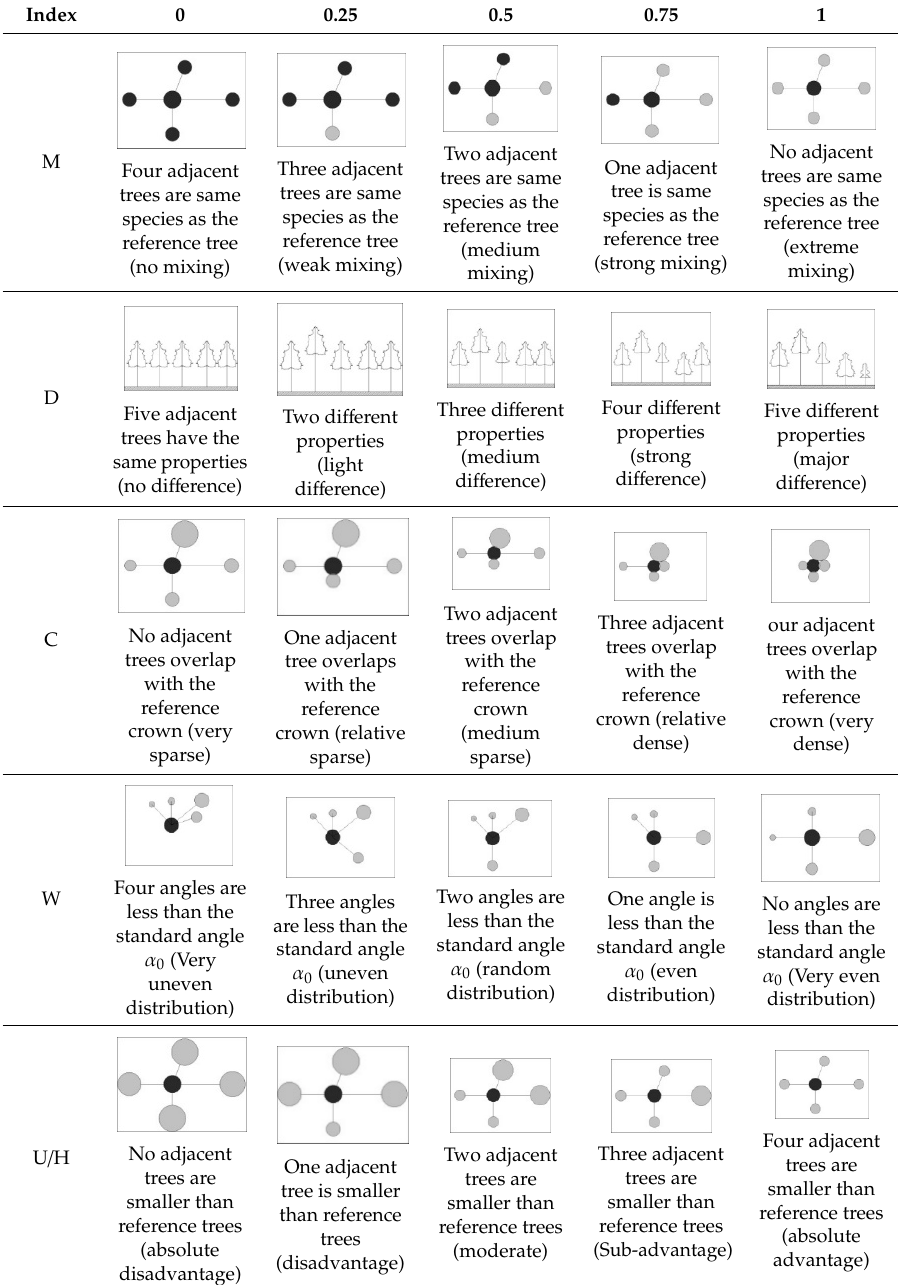
Table 1. Forest spatial structure index system.